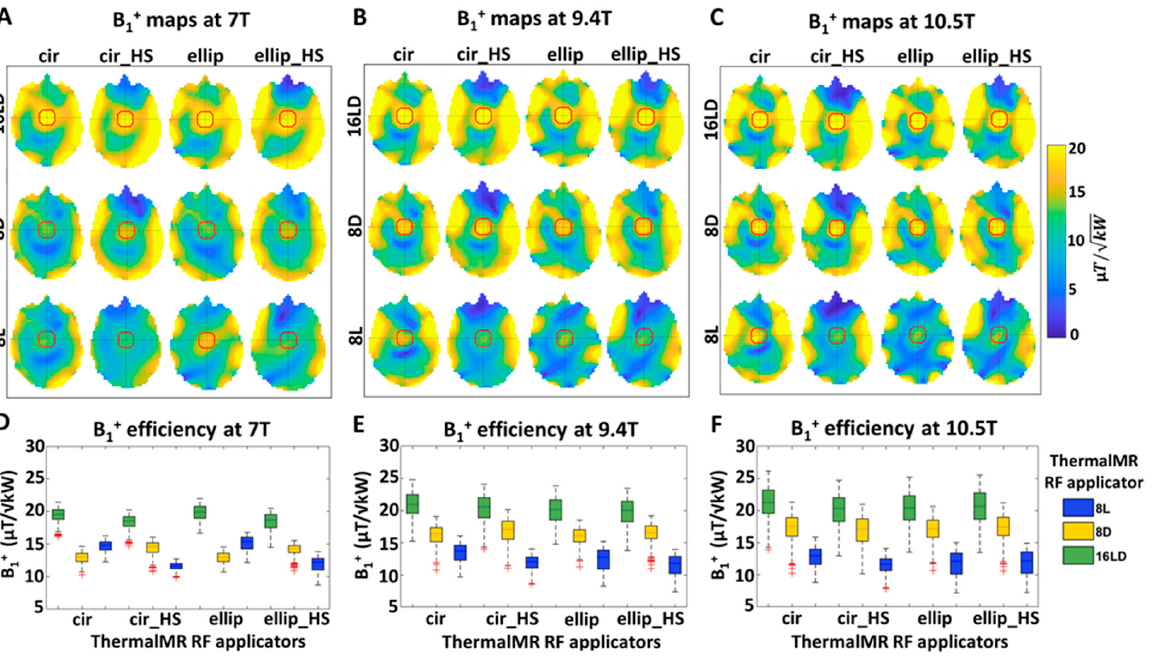
Figure 5. B 1+ distribution maps (central axial slice of the head of the human voxel model Duke) of 16LD, 8D and 8L ThermalMR RF applicators cir, cir_HS, ellip, ellip_HS at magnetic field strength of ( A ) 7.0 T, ( B ) 9.4 T, ( C ) 10.5 T in circular polarization mode for a spherical region of interest (ROI) (radius = 2 cm, red circle) centered in the head of the human voxel model Duke. All four 16LD ThermalMR RF applicators show enhanced B 1+ distribution inside the ROI compared with the corresponding 8D and 8L ThermalMR RF applicators. Comparison of the B 1+ efficiency in the ROI for the 16LD, 8D and 8L ThermalMR RF applicators variants cir, cir_HS, ellip, ellip_HS at field strengths ( D ) 7.0 T, ( E ) 9.4 T, ( F ) 10.5 T shows increasing mean and maximum B 1+ with increasing B 1+ compared to the 8D and 8L variants (see Table